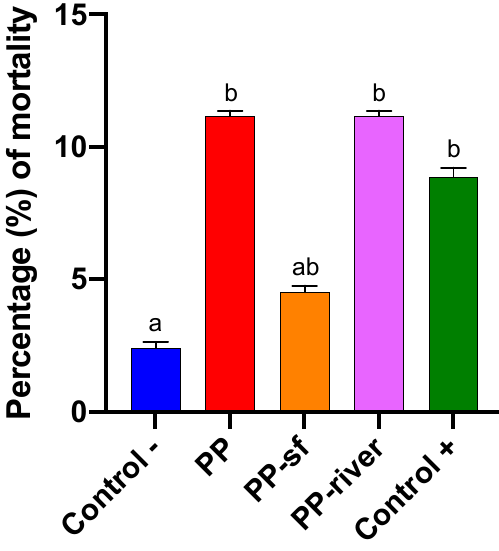
Figure 4. Mortality of Hydropsyche pellucidula for each treatment group (Control − denotes positive control; PP polypropylene unconditioned; PP-sf polypropylene preconditioned in Triton X-100 solution; PP-river polypropylene preconditioned in riverine water; Control+ negative control) expressed as percentage (%). Lowercase letters (a, b) denote differences revealed by Conover-Iman post-hoc test.